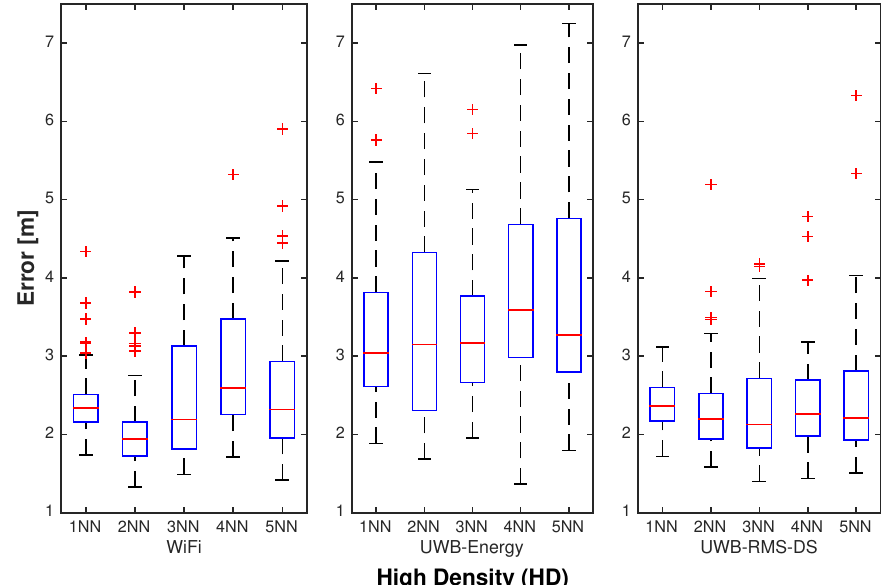
Figure 5. Statistics of positioning error (cid:101) in high density (HD) scenario for WiFi, ultra-wideband (UWB)-energy and UWB root-mean-square delay spread (RMS-DS) with fixed k -nearest neighbor ( k NN) algorithm ( k = { 1,2,3,4,5 }